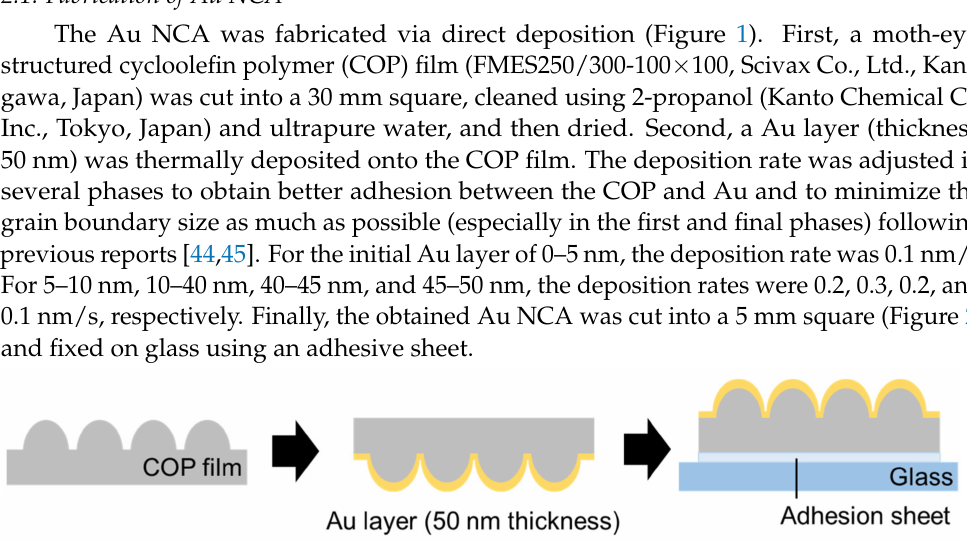
Figure 1. Fabrication procedure of Au NCA using direct deposition.